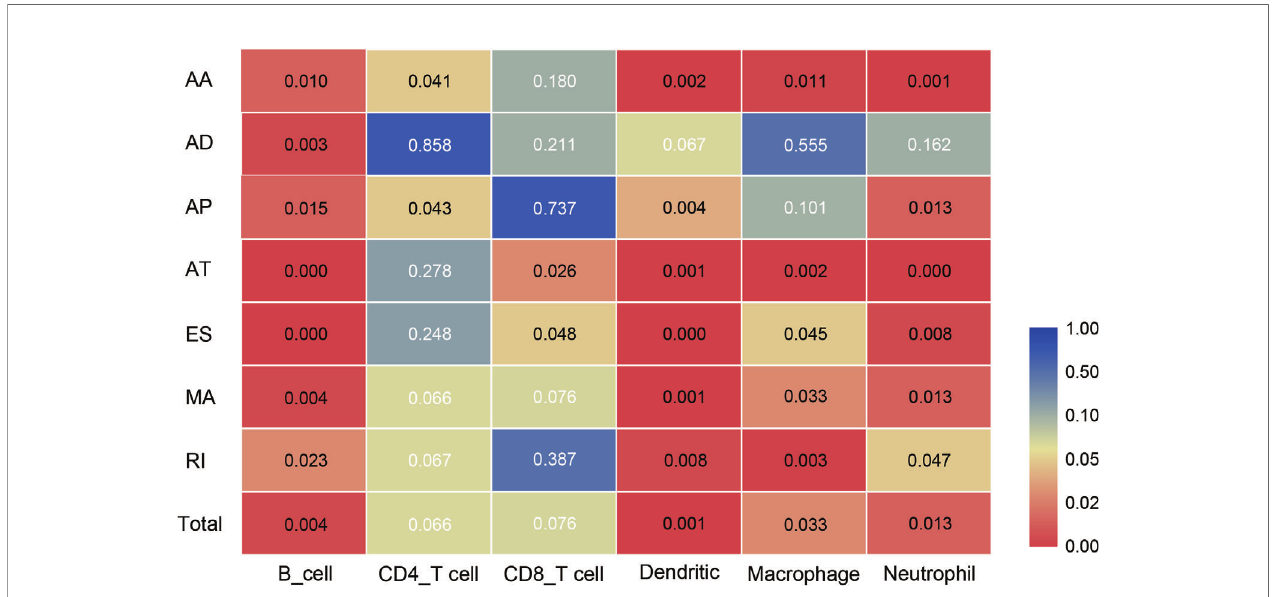
FIGURE 10 | Heat map showing differences in the in fi ltration of six immune cell types in the low-risk and high-risk groups of different AS events. Colors from blue to red represent high to low P -values, and yellow represents P =